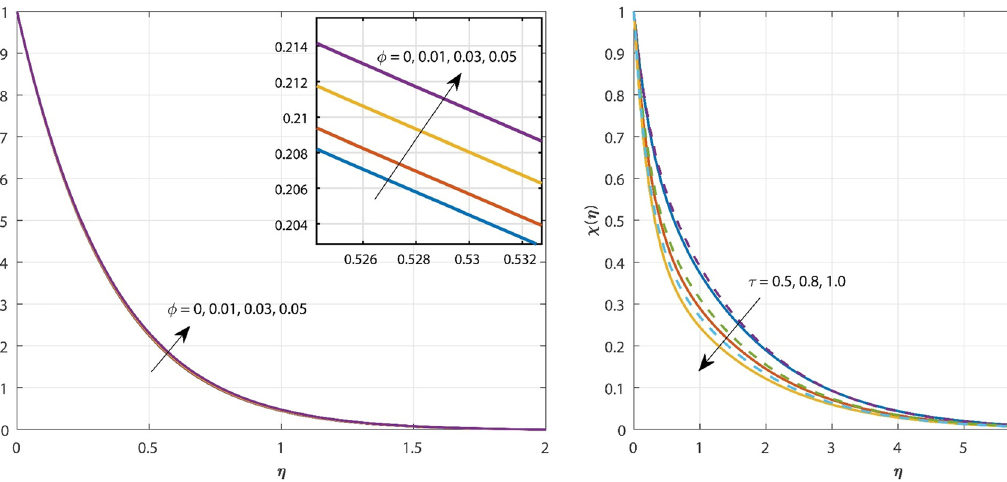
Figure 7: Plot of θ ( η ) over di ff erent values of ϕ .